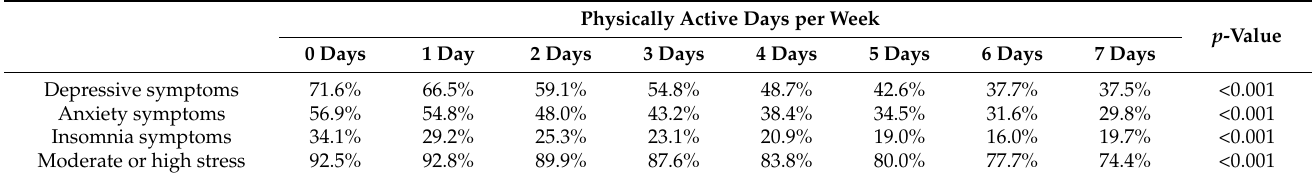
Table 5. Proportion of participants exceeding the cut-off scores for moderate depressive, anxiety, insomnia, and stress symptoms by physical activity.